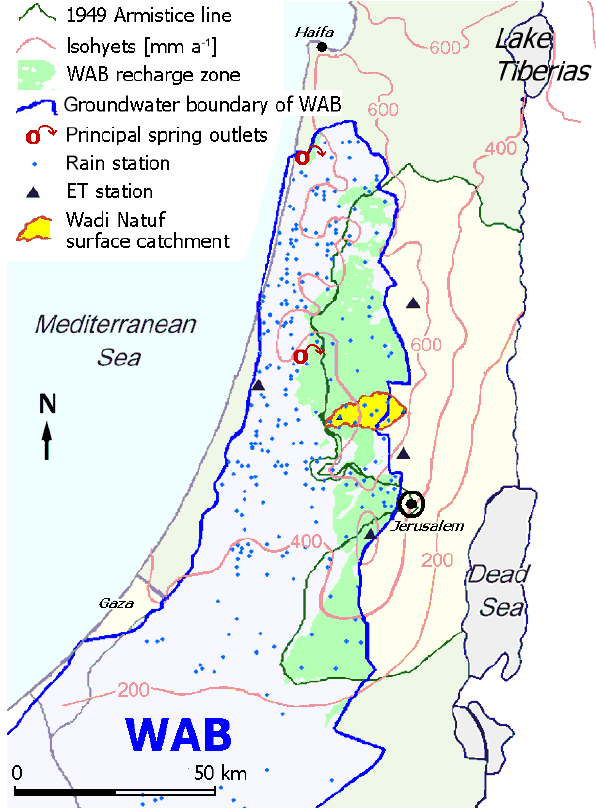
Figure 1. Western Aquifer Basin (WAB) overview and Natuf loca- tion map. Wadi Natuf (in yellow) lies in the uphill recharge zone (shaded green) of the groundwater of the Western Aquifer Basin, whereas the easternmost part of its surface catchment belongs to the Western Aquifer Basin. Isohyets indicate a climate in Wadi Natuf ranging from semi-arid to sub-humid. The two former principle spring outlets of the WAB have all but dried up, due to excessive pumpage in Israel. Four evapotranspiration (ET) stations around Wadi Natuf were complemented by two automatic weather stations in this study. Sources: modified after Sheffer et al. (2010), SUS- MAQ (2001), Abusaada (2011) and ESCWA-BGR